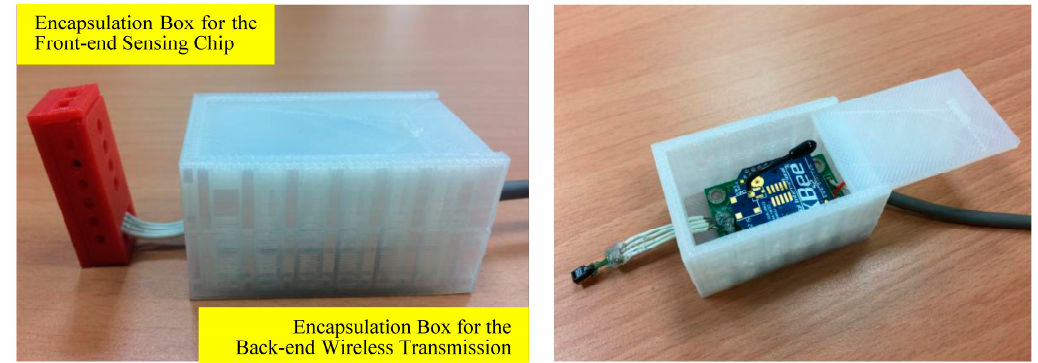
Figure 6. Encapsulation design for the separable RH/T microsensor.